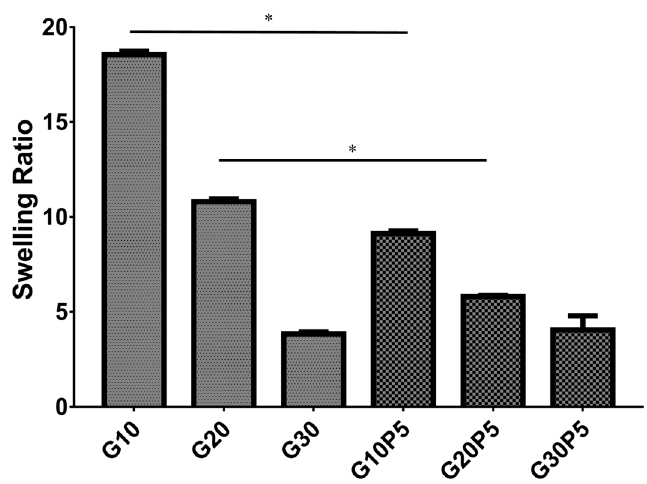
Figure 3. Swelling ratio of GelMA and GelMA/PEGDA hydrogels in PBS solution at room temperature (* P < 0.05).